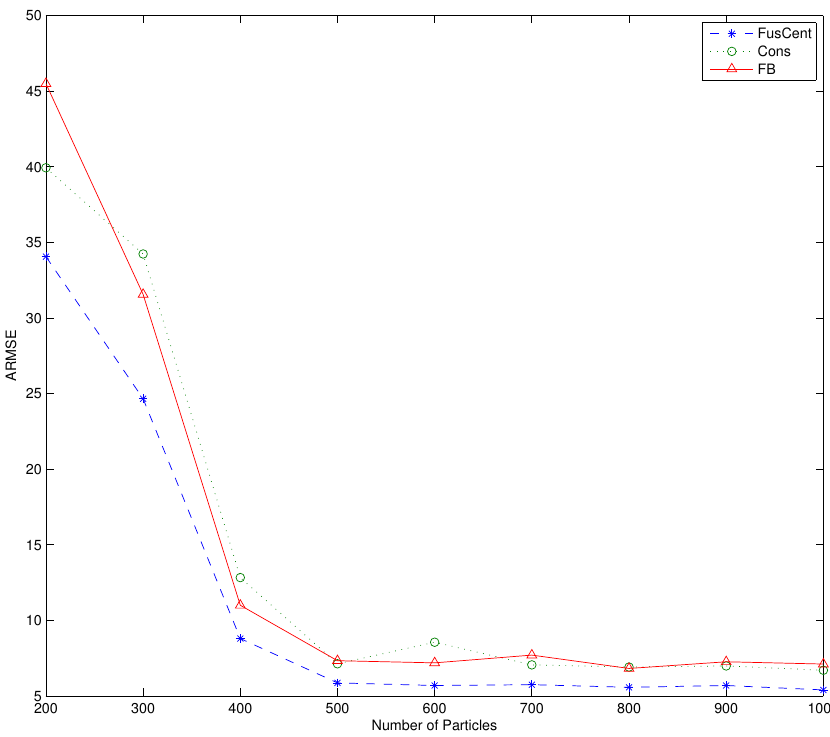
Figure 3. Averaged Root Mean Square Error (ARMSE) versus particle size.